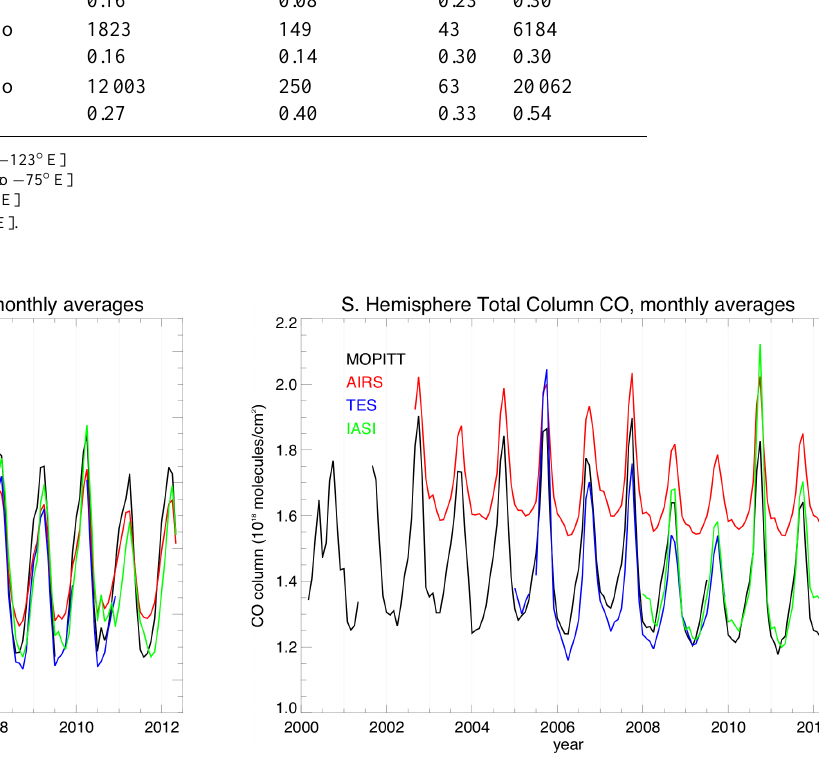
W (cm − 2 sr cm − 1 )): − 0.15 × 10 − 9 < = bias < = 0.25 × 10 − 9